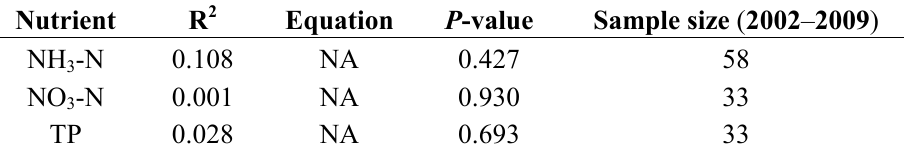
Table 3. Relationship between watershed impervious cover percentage and nutrient loading in Site 1 (Panther Creek watershed, The Woodlands green infrastructure development).